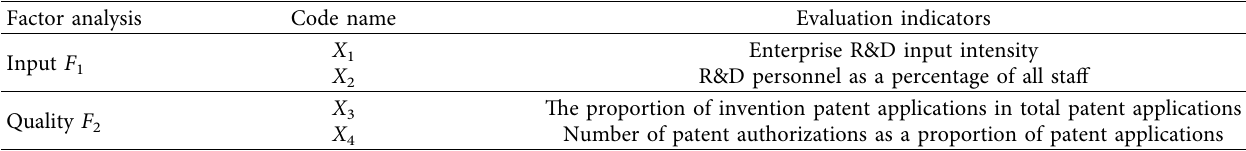
Table 1: Enterprise innovation evaluation system.